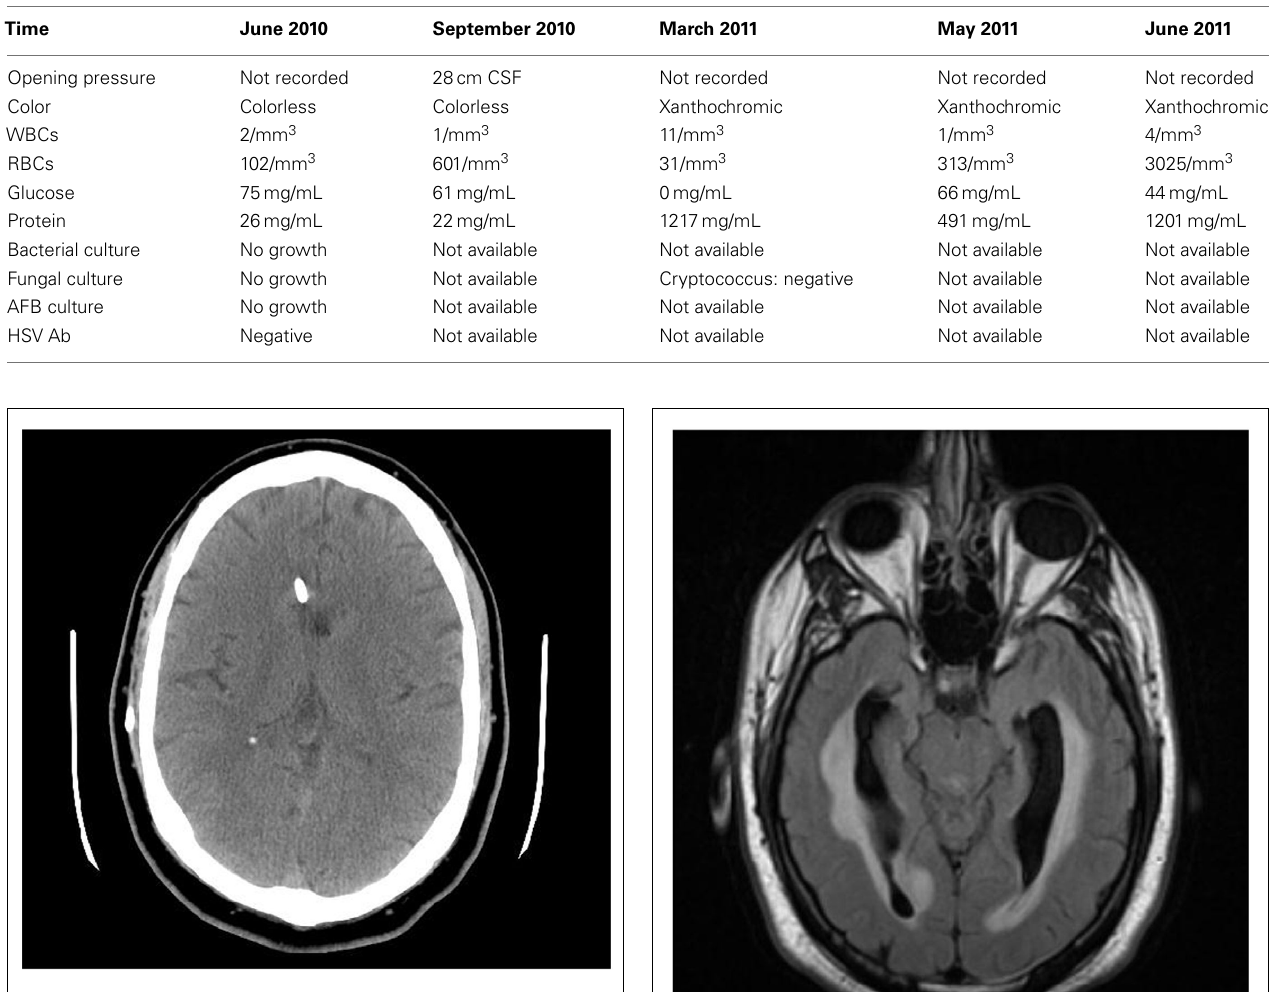
Table 1 |Temporal profile of CSF analysis.